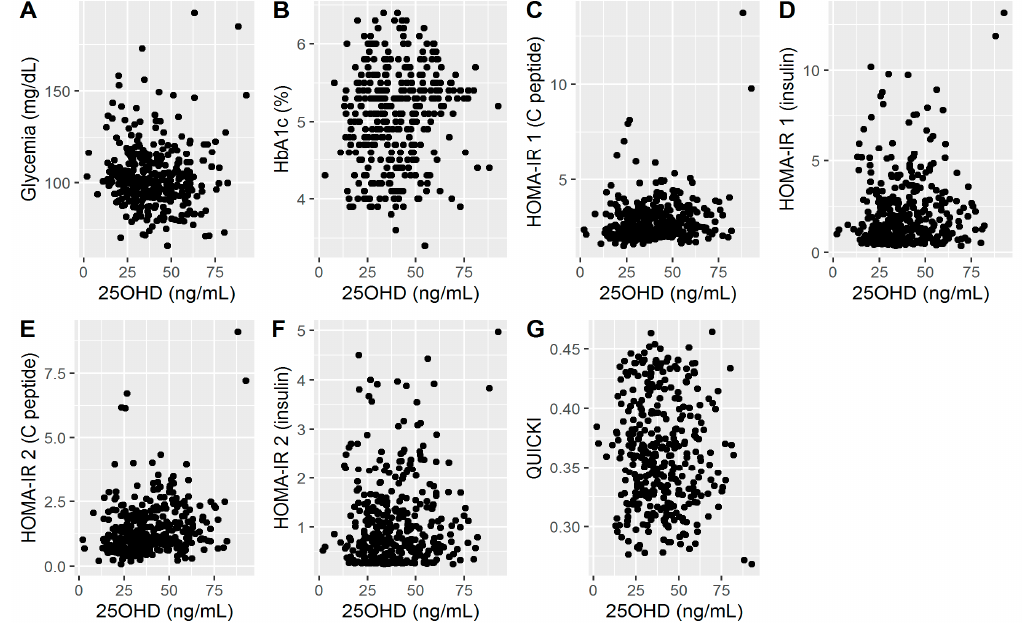
Figure 1. ( A ). Associations between 25OHD and glycemia; ( B ). Associations between 25OHD and HbA1c; ( C ). Associations between 25OHD and HOMA-IR1 (C peptide); ( D ). Associations between 25OHD and HOMA-IR1 (insulin); ( E ). Associations between 25OHD and HOMA-IR2 (C peptide); ( F ). Associations between 25OHD and HOMA-IR2 (insulin); ( G ). Associations between 25OHD and QUICKI.